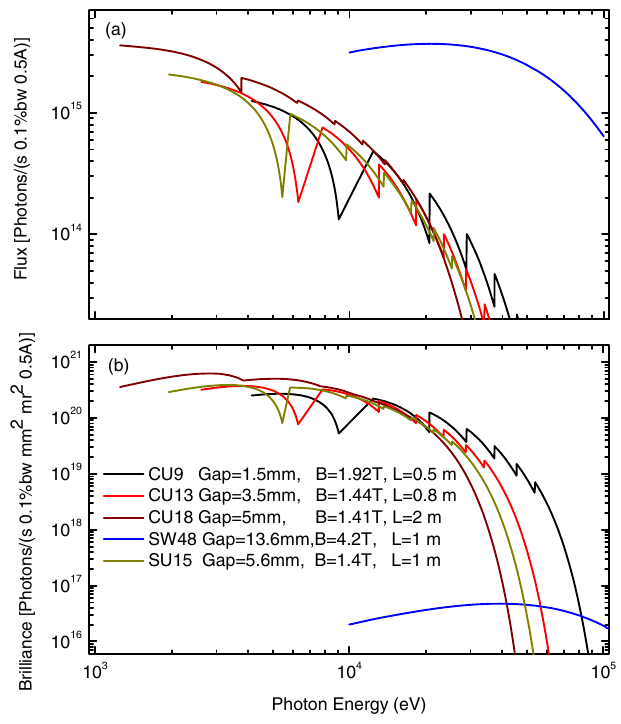
FIG. 1. Possible hard x-ray energy spectrum in an advanced medium-energy storage-ring facility: (a) flux, (b) brilliance. Energy spread 0.1% and phase error 2 (cid:3) were used to calculate the flux and brilliance in the TPS lattice parameters.